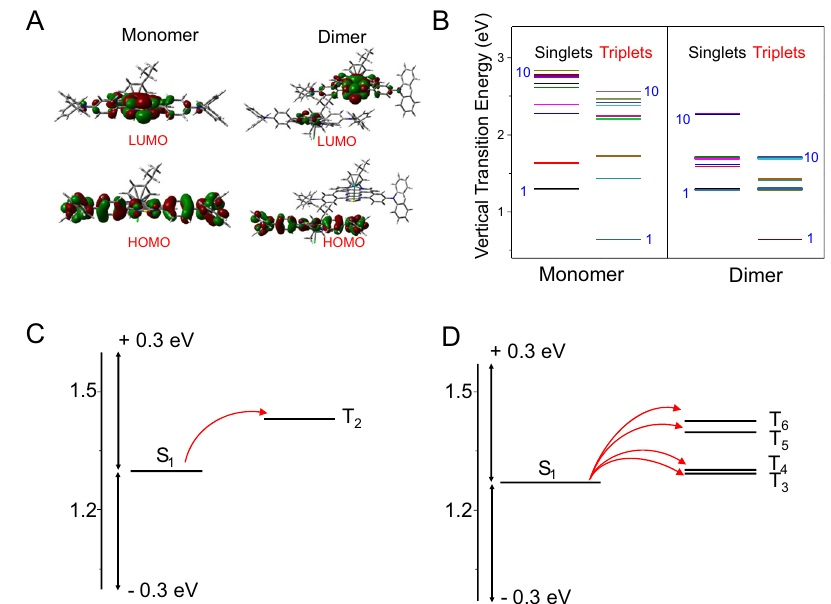
Fig. 3 Quantum-chemical calculations of RuDA. A Calculated HOMOs and LUMOs of RuDA in monomeric and dimeric forms. B Singlet and triplet energy levels of of RuDA in monomer and dimer, respectively. C Calculated energy levels and possible ISC channels of RuDA in monomeric C and dimeric D forms. The arrows refer to the possible ISC